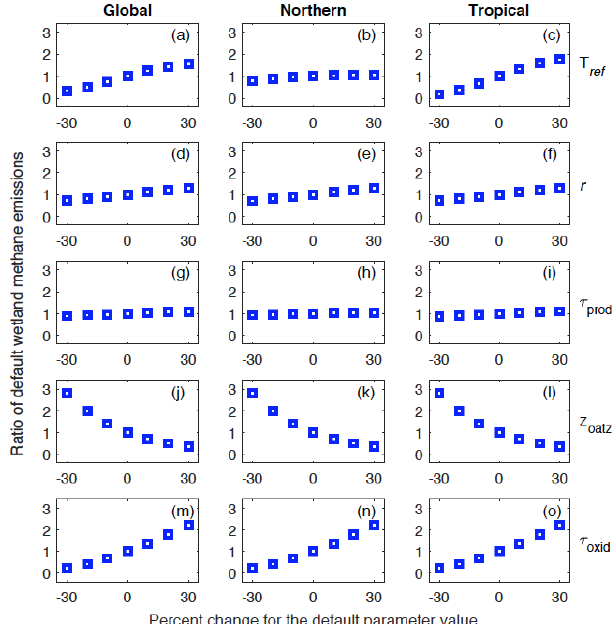
Figure 12. Analysis of the model sensitivity to perturbations of poorly constrained parameters: T ref , r , τ prod , z oatz , and τ oxid . For each parameter, the default value is increased or decreased by 10%, 20%, and 30% while values of other parameters are held constant (to default values). The model sensitivity is analyzed with respect to global (90 ◦ S–90 ◦ N), northern (45–90 ◦ N), and tropical (30 ◦ S– 30 ◦ N) wetland methane emissions. Vertical axes show the ratio of the resulting emissions to the default